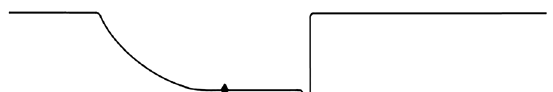
Both areas S 0 and S 1 were calculated using a simple trapezoid numerical scheme. Tests of the dependence of the results on the grid size show very weak sensitivity and fast convergence with increasing resolution. For all ◦ × 1 ◦ calculations we used a 1 grid in longitude and co- latitude. With this grid size, the computed properties (i.e. the area and coordinates of the center) practically reach asymptotic values with decreasing grid